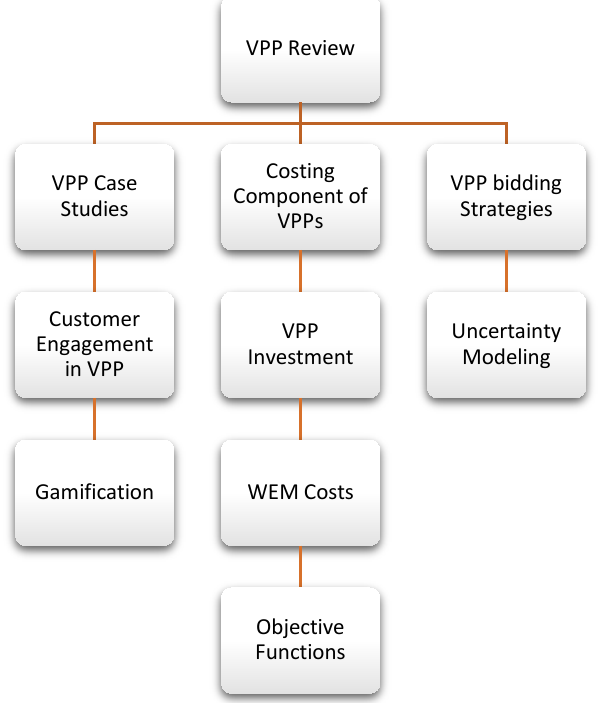
Figure 1. The components of the literature review in this article.